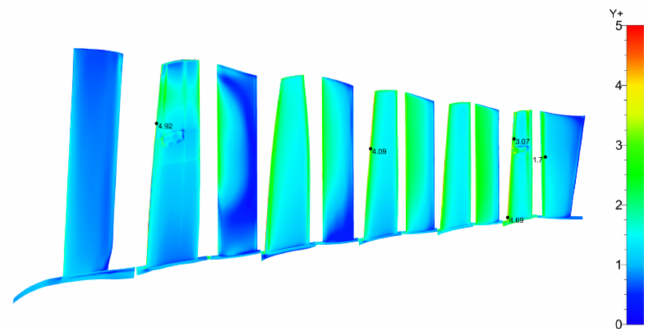
Figure 4. Y + distributions for all blade